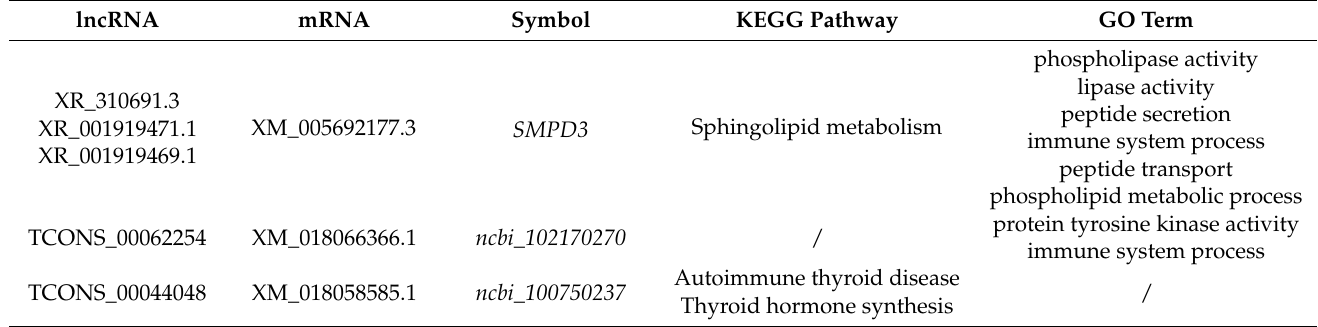
Table 5. Functional enrichment analysis results of part antisense lncRNA target mRNAs.